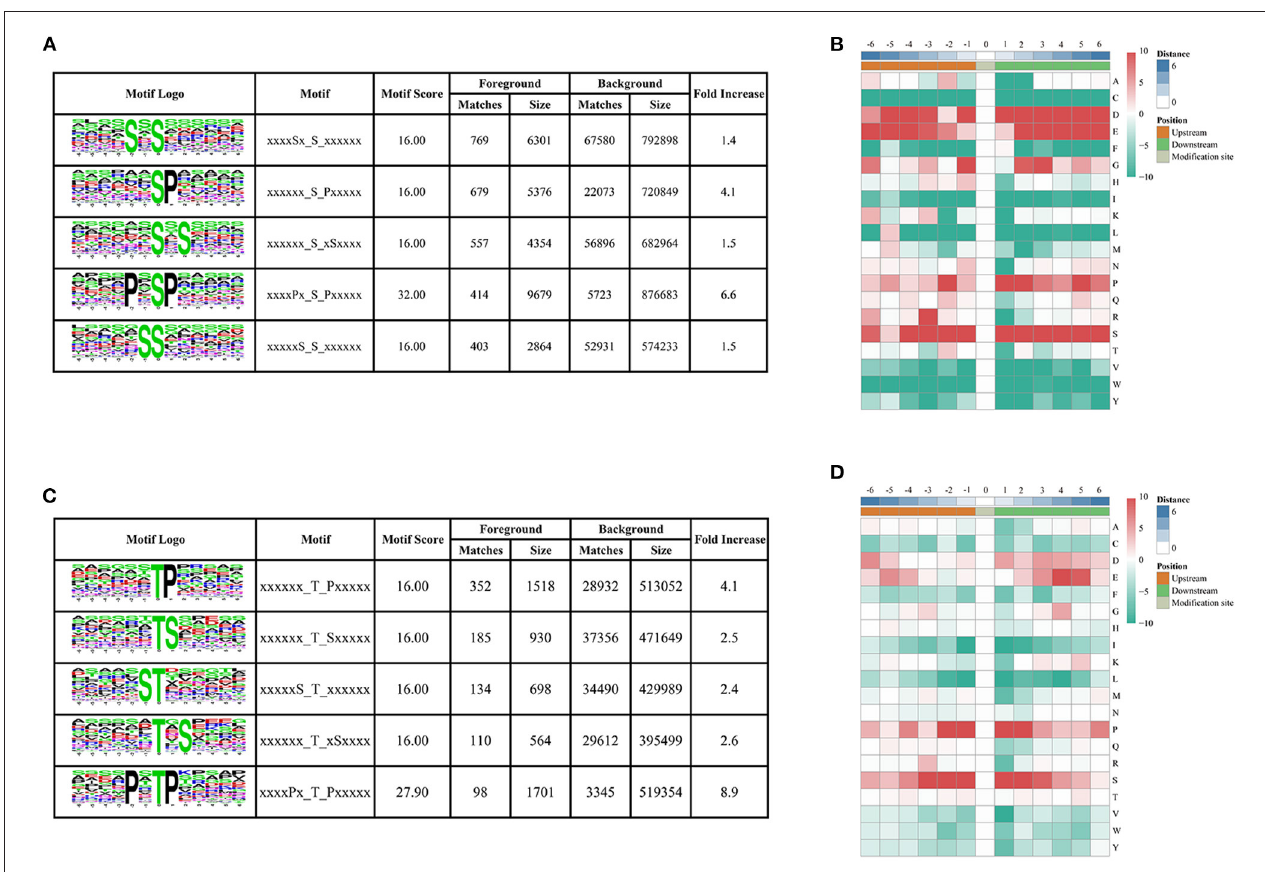
FIGURE 3 | Motif analysis of phosphorylated peptides. (A,C) Top five serine and threonine phosphorylation motifs; (B,D) sequence probability logos of significantly enriched phosphorylation site motifs for six amino acids around the serine and threonine phosphorylation